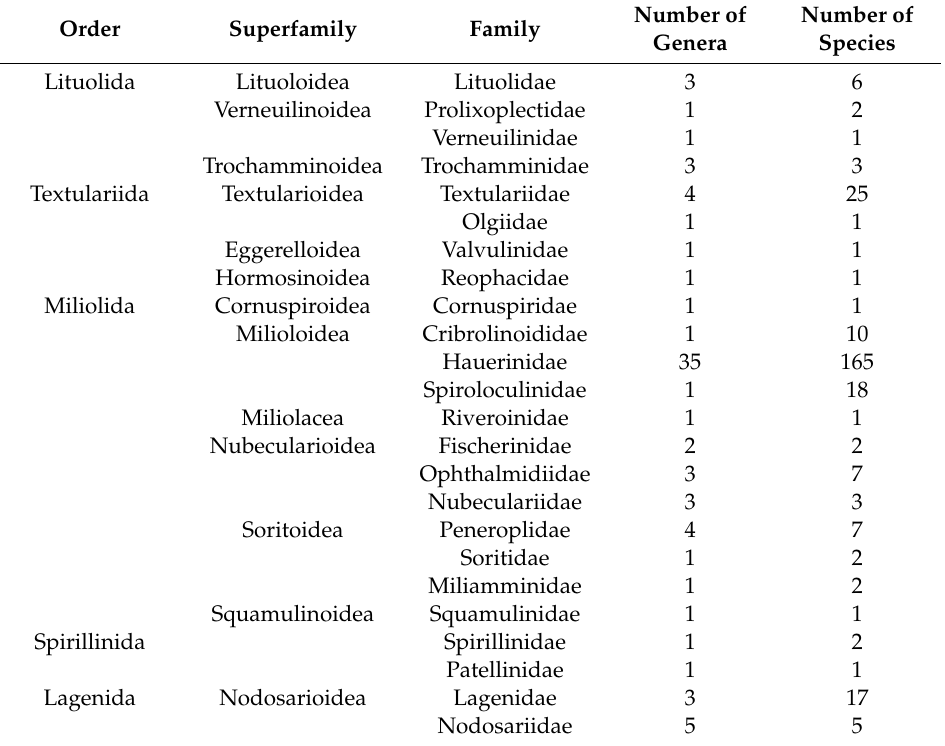
Figure 2. Geographical locations of the stations in this study: ( a ) around Auha, Failaka and Miskan Islands; and ( b ) within the Kuwait Bay. Table 1. Benthic foraminiferal taxa (order, superfamily and family) and number of genera and species recognized in Kuwait territorial